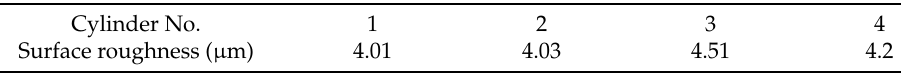
Figure 13. Surface roughness according to feed rate. Table 8. Surface roughness of each cylinder.